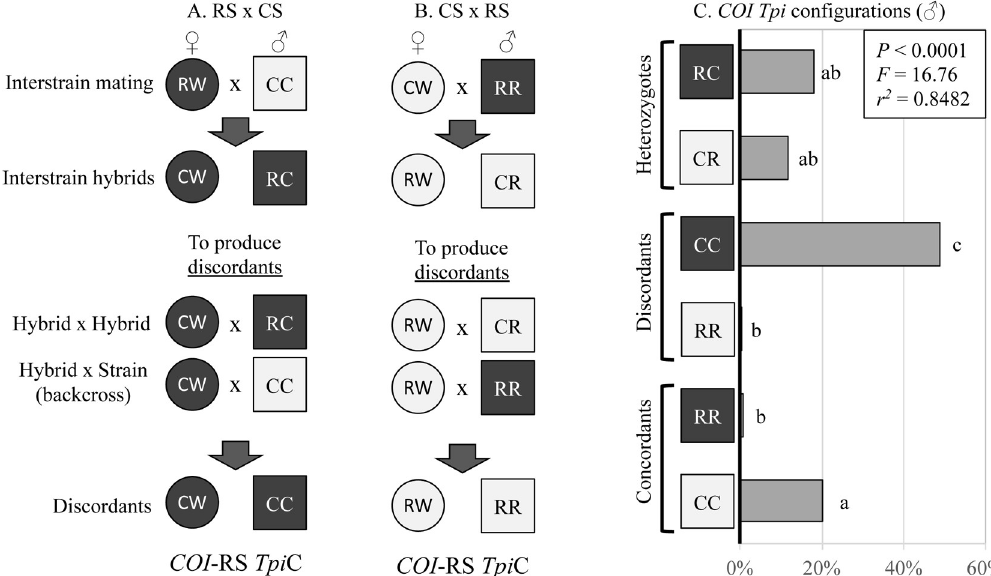
Fig 7. Mating scenarios to produce Tpi heterozygotes and COI Tpi discordant genotypes their relative frequencies in extrapolated male specimens from Africa. The Tpi R (R) and Tpi C (C) alleles are defined by the e4 183 polymorphism. Females are designated by a circle and are hemizygous for Tpi and so can only carry one Tpi allele, while males (square) and are either homozygous (RR, CC) or heterozygous (RC, CR) for Tpi R and Tpi C. Dark shading indicates a COI -RS mitochondrial haplotype while light shading identifies COI -CS. A) Female rice-strain (RS) mating male corn-strain (CS), while B) represents the reciprocal cross. C) Graph of the frequencies of each COI Tpi configuration within the male subset of the data described in Fig 3B (see text for explanation). Lower case letters indicate significant differences as determine by ANOVA and Tukey’s multiple comparison test.